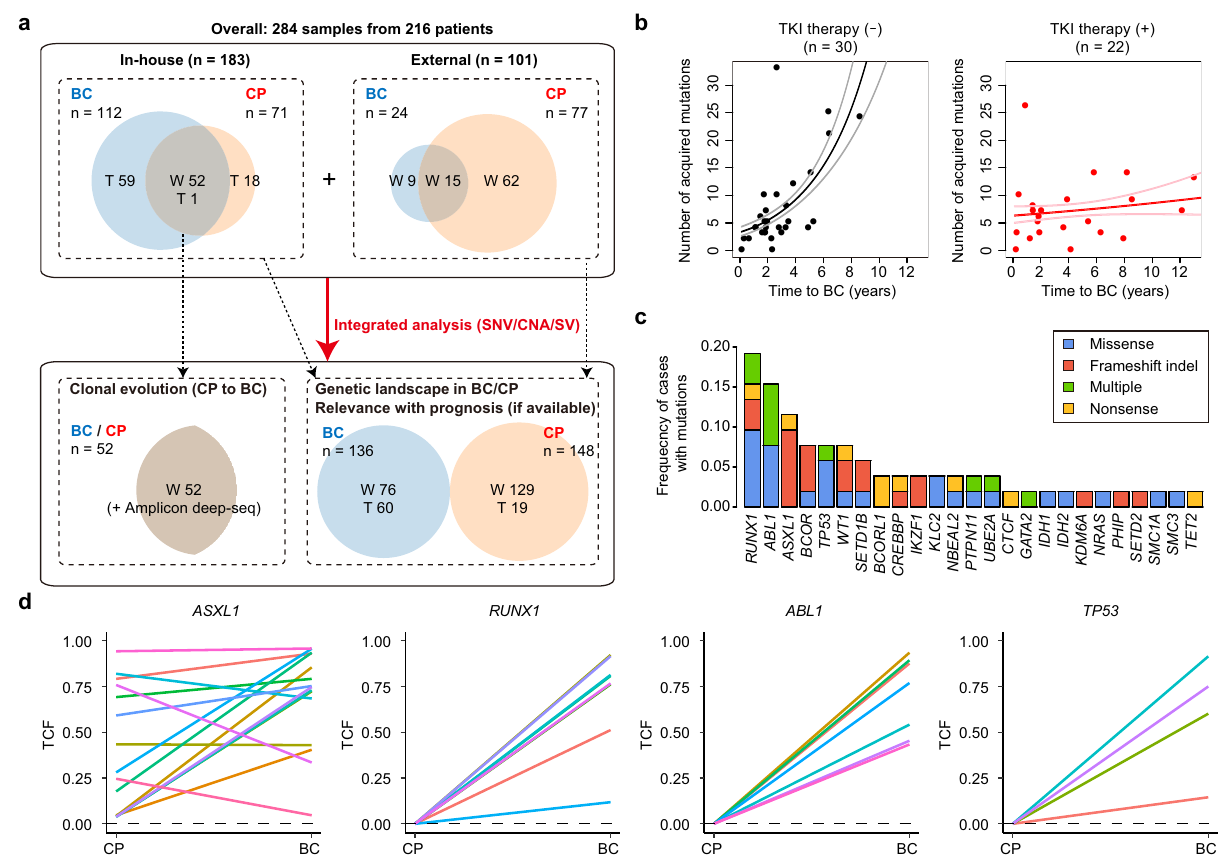
Fig. 1 Somatic mutations acquired during clonal evolution in CML. a Scheme demonstrating the study cohort. Numbers indicate analysed samples. Numbers in overlapping regions of CP and BC circles indicate the number of cases analysed for both CP and BC. W whole-exome sequencing, T targeted capture sequencing. b Scatter plots for time to progression (horizontal axis) and number of acquired SNVs (vertical axis) during progression from CP to BC in 52 cases for whom WES was performed, using paired CP and BC samples. Regression lines with 95% con fi dence intervals were also plotted. Cases with or without TKI therapy after CP diagnosis are indicated separately. c Frequencies of mutations acquired during evolution from CP to BC in 52 cases. Recurrently acquired or known driver genes are described. Categories of mutations are depicted in different colours, and “ multiple ” indicates ≥ 2 distinct mutations found in the same gene in the same patient. d TCFs of the indicated mutations in the corresponding CP and BC samples determined by conducting deep amplicon sequencing. Black dashed lines indicate a TCF of 0%. Colours represent individual